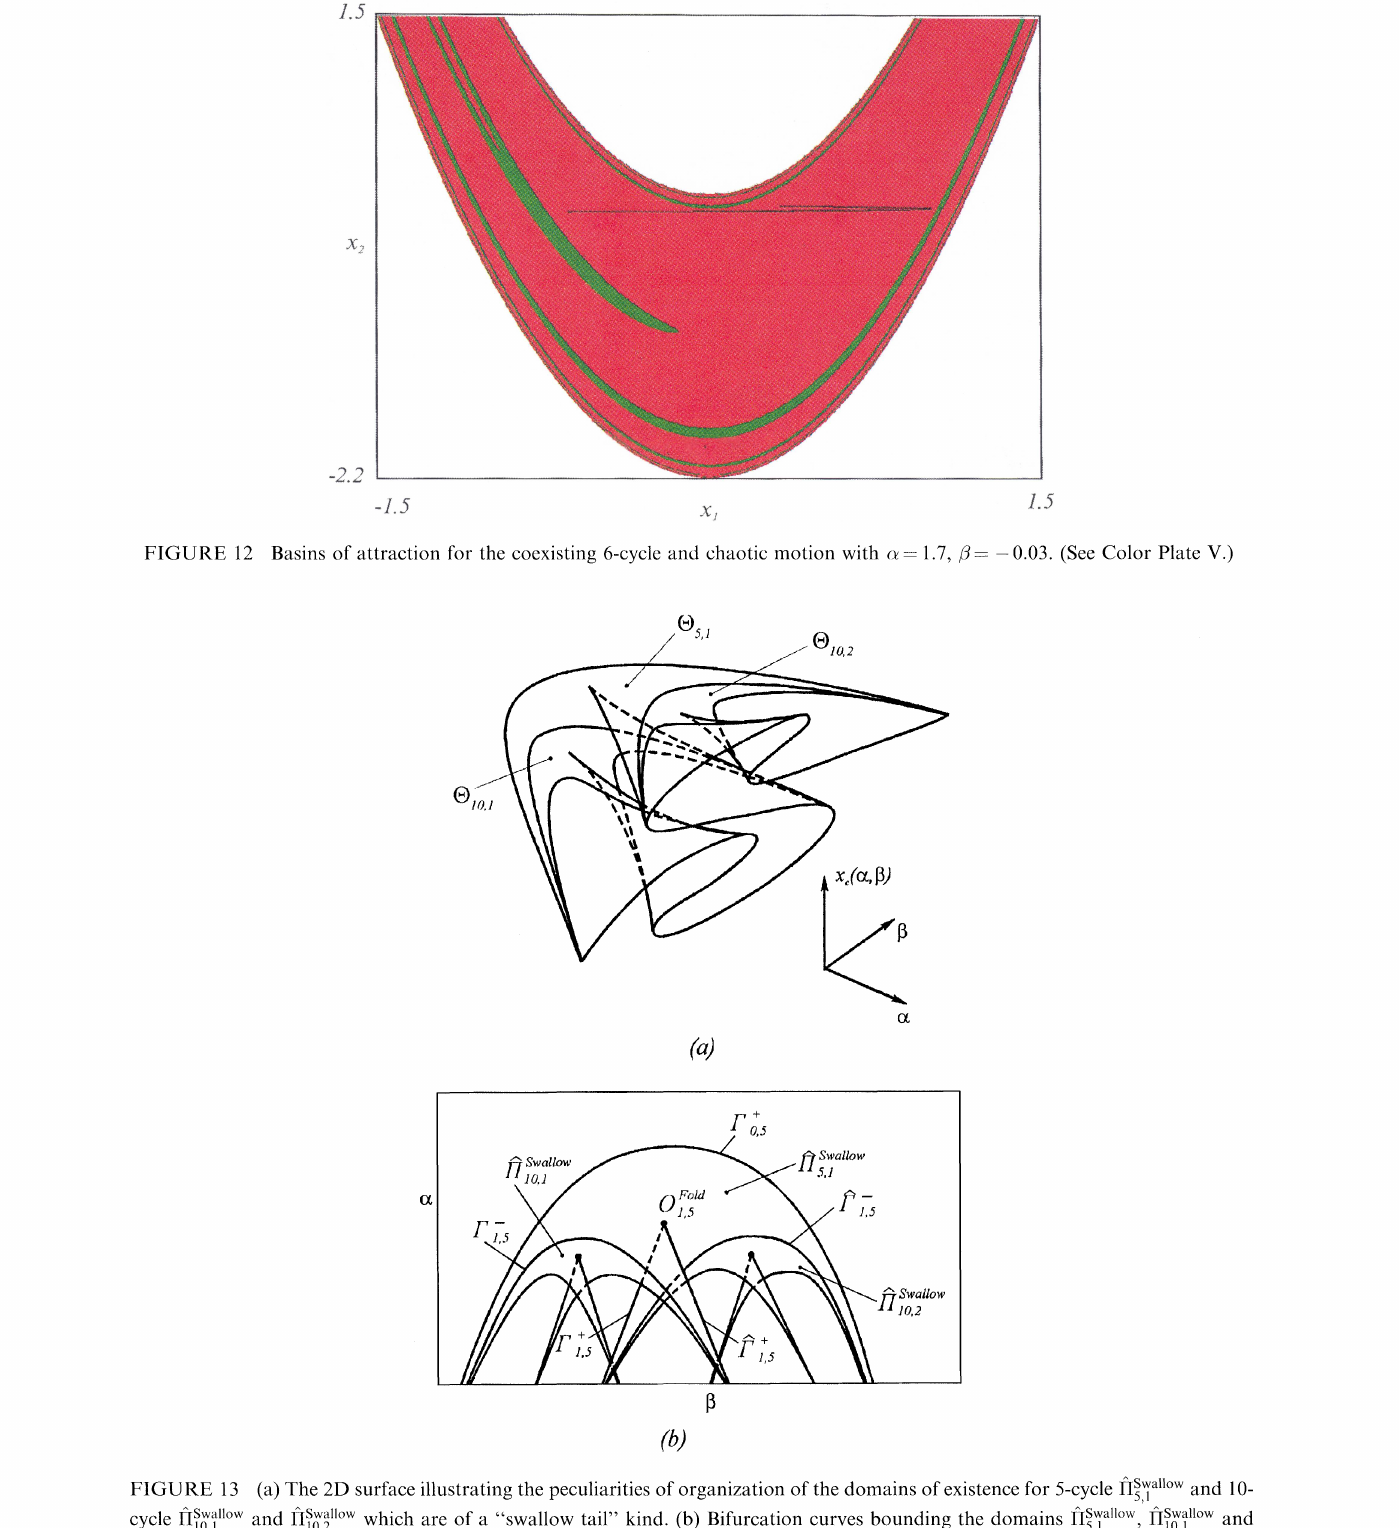
FIGURE 13 (a) The 2D surface illustrating the peculiarities of organization of the domains of existence for 5-cycle It iallow and 10- cycle ~SO,ill°" and Ilso211ow which are of a "swallow tail" kind . (b) Bifurcation curves bounding the domains H a11o`" fl Mow and nso zlloW Note that both plots are not drawn to scale